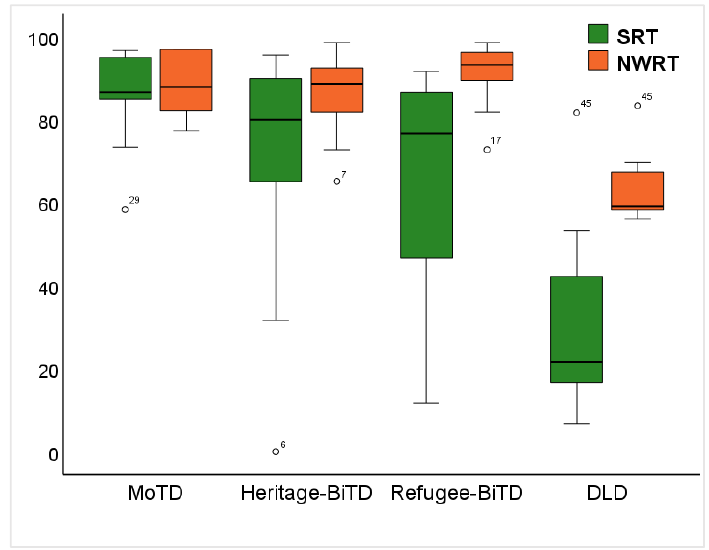
Figure 2. Group performance on LITMUS-SRT (scored by target structure) and NWRT with cut-off points according to Hamann and Abed Ibrahim (2017). Table 3. Proportion of BiTD children identified as language impaired using single (without and with dominance adjustment) and combined measures (total Ns and percent).